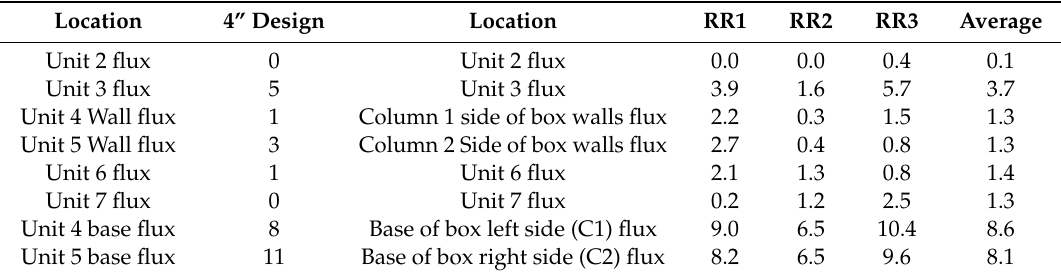
Table 11. Wall deposition fluxes (g / m 2 / h) for a 8.8 wt% solids concentration feed at an inlet air for Unit 3 and the base of the box and 0.53 g / m 2 / h for all other fluxes.